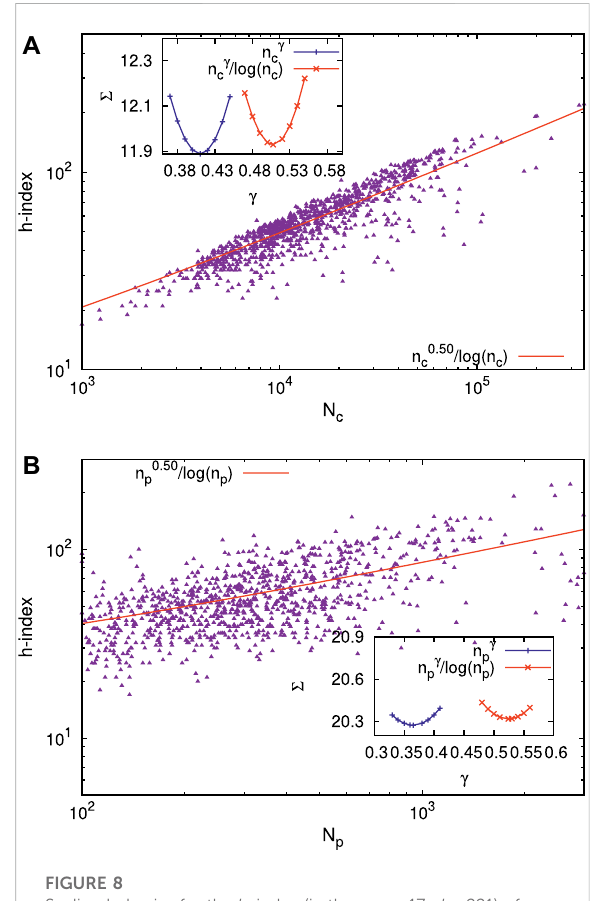
FIGURE 8 Scaling behavior for the h -index (in the range 17 ≤ h ≤ 221) of 1000 scientists with the total number of citations N c (in the range 996 ≤ N c ≤ 348680)in (A) andwiththetotalnumberofpapers N p (in the range 100 ≤ N p ≤ 2987) in (B) . The data are taken from Google Scholar in June 2021. The fi gures show the best fi ts to (cid:1)(cid:1) √ (cid:1)(cid:1) √ (cid:4) (cid:1)(cid:1)(cid:1)(cid:1)(cid:1)(cid:1)(cid:1)(cid:1)(cid:1)(cid:1)(cid:1)(cid:1)(cid:1)(cid:1)(cid:1)(cid:1)(cid:1)(cid:1)(cid:1) h ~ N N c /log N c in (A) and to h ~ p / logN p in (B) . The insets show ( h ( i ) − h γ ( i )) 2 / Σ Σ to the scaling the statistical deviations Σ (cid:3) i d i 1 forms h ~ N γ p (or h ~ N γ c ) and h ~ N γ p / log ( N p ) (or h ~ N γ c / log ( N c ) ) with respect to γ , where i represents the individual scientist with the corresponding h (= h d ) value obtained from Google Scholar and the scaling fi t ( h γ ) from the aforementioned scaling relations. The inset shows that although the statistical deviation does not become minimum for the scaling with the log correction term (presumably due to inclusion of some tail-end points), the best fi t for γ assumes the desired value